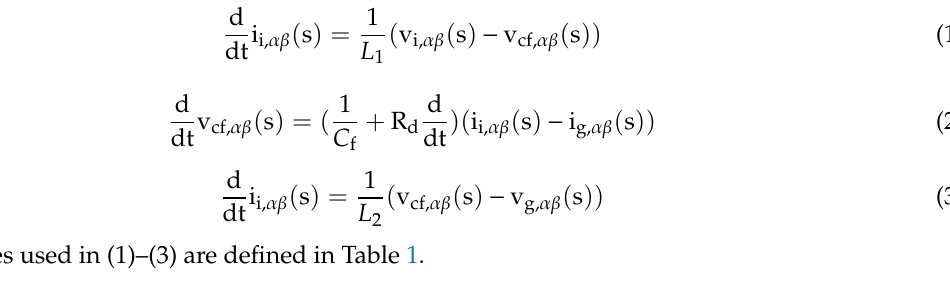
Table 1. Definition of variables in a grid-connected inverter (GCI) current control system.